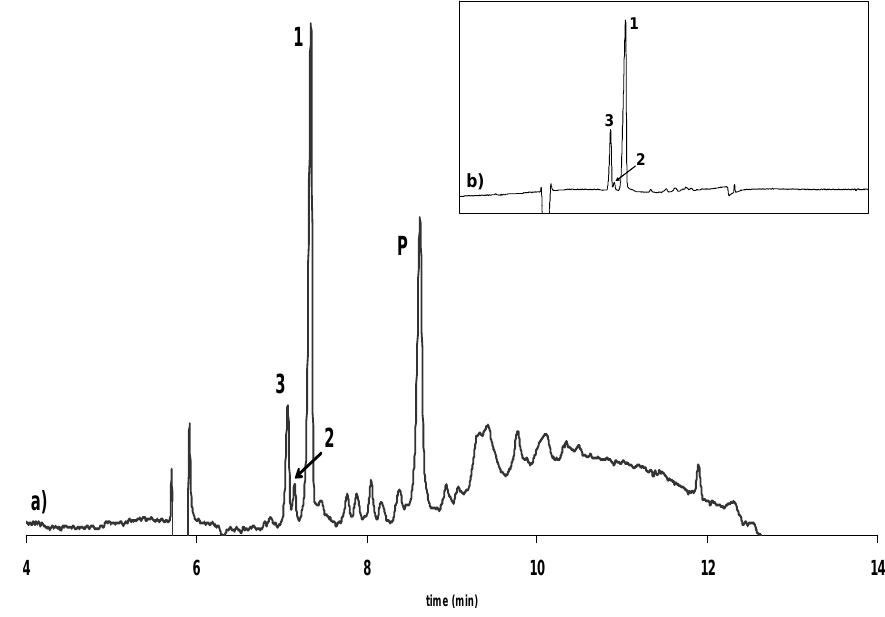
Figure 3 . Electropherogram showing the enantioselective separation of catechin and epicatechin in a) an extract of roasted cocoa beans and b) isolated from this extract. 1: (-)-Epicatechin, 2: (+)-Catechin, 3: (-)-Catechin, P: Procyanidin B2. Experimental conditions as in Figure